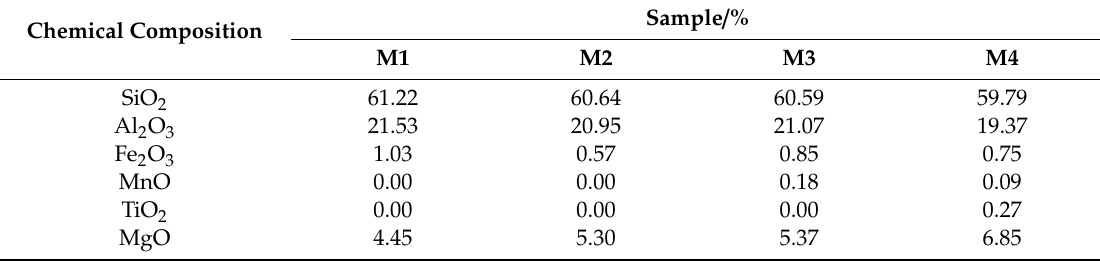
Figure 1. X-ray diffraction analysis of four kinds of purified montmorillonite. Figure 1. X-ray di ff raction analysis of four kinds of purified montmorillonite. Table 1. Chemical composition of four kinds of purified Table 1. Chemical composition of four kinds of purified montmorillonite.